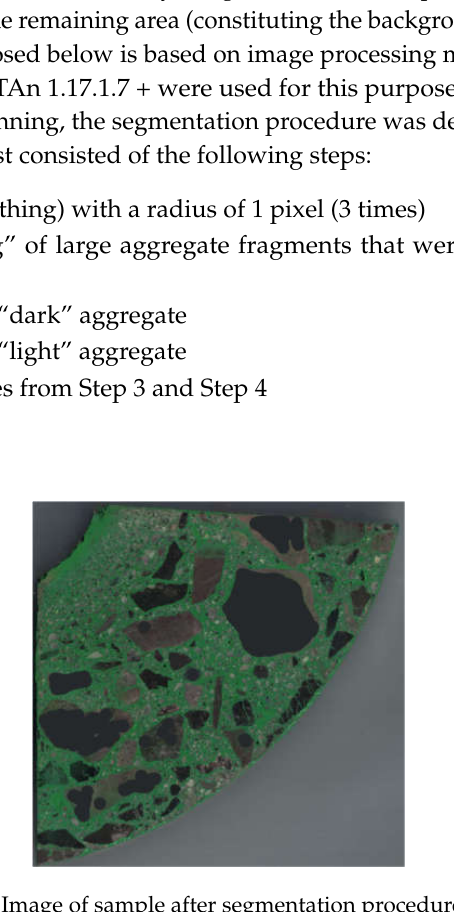
Figure 5. Scan of spun concrete element cross section after matrix dyeing (scale 1:1).